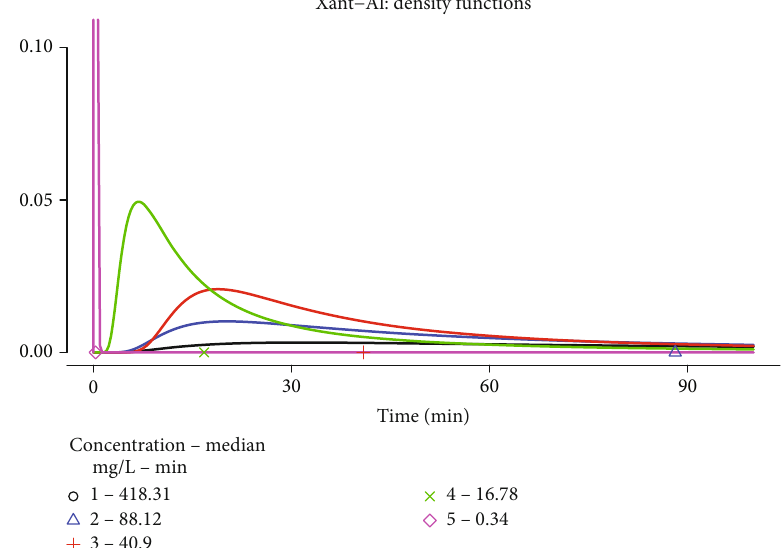
Figure 8: Density functions of the time ( t medium for fi ve di ff erent initial fl uoride